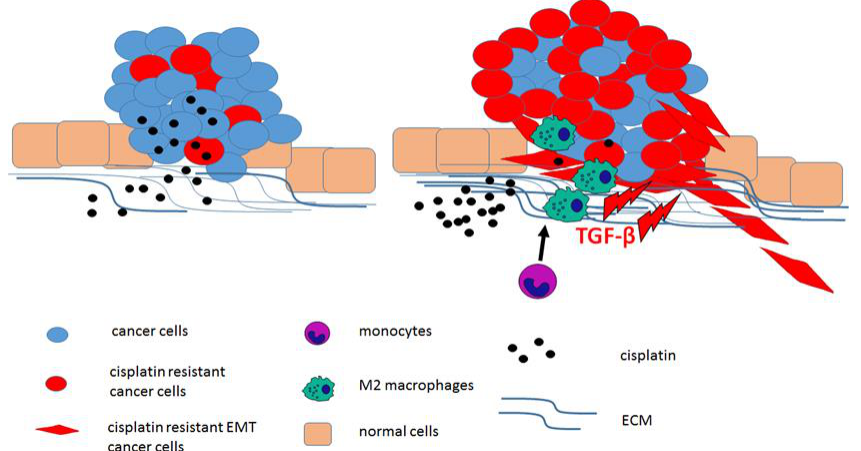
Figure 2. TME impact on cisplatin resistance. Cisplatin administration leads to the selection and acquisition of cisplatin-resistant cancer cells. The TME restricts the diffusion rate of cisplatin. Cisplatin-resistant cancer cells support the activation of M2 macrophages, which in turn induce EMT via TGF- β secretion , resulting in enhanced chemoresistance and metastatic potential.